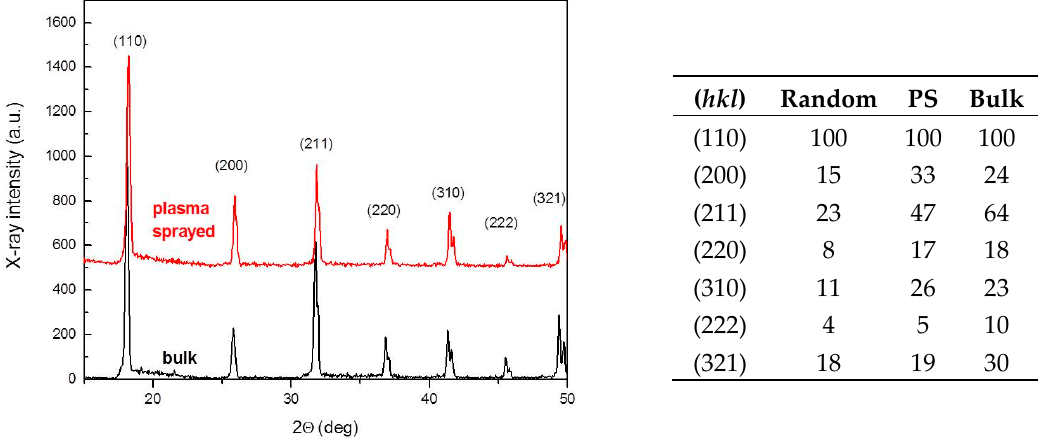
Figure 2. XRD spectra of bulk and plasma-sprayed W. The table summarizes the relative intensities of main reflections and compares these values with those of W with random oriented grains.